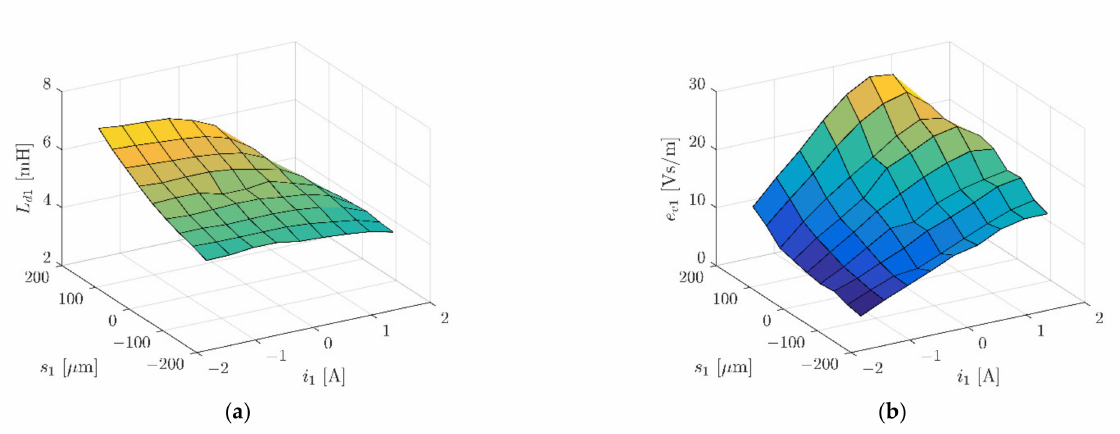
Figure 8. Magnetic force F x ( a ) and magnetic force F y ( b ) as a function of the rotor position y and control current i y .